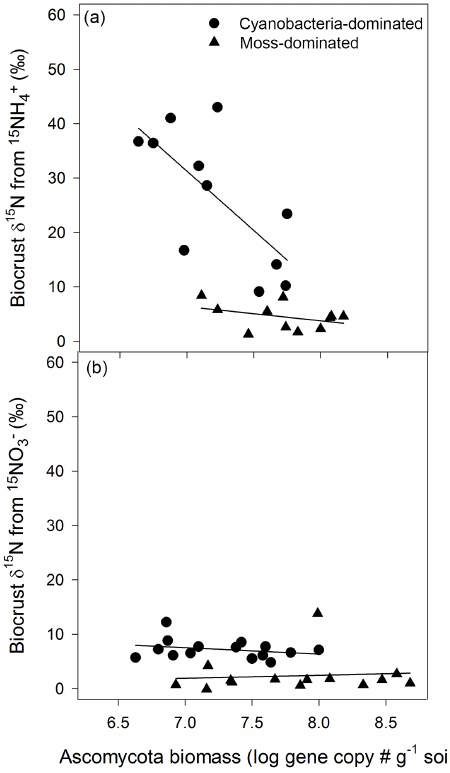
Figure 2. Ascomycota biomass influenced the distance N traveled. In cyanobacteria crusts, δ 15 N, from 15 NH + Figure 1. Cyanobacteria biocrusts facilitated the translocation of N Ascomycota gene copy number increased ( R 2 = 0 . 63, F 2 , 8 = 6 . 8, from 15 NH + in 24h. Based on linear mixed effects models, δ 15 N, 4 P = 0 . 02)( a ). A similar pattern was not apparent in any other crust from 15 NH + , ( R 2 = 0 . 67, F 2 , 12 = 11, P = 0 . 002), decreased as 4 type or N form (a, b) . Values are δ 15 N (‰) from biocrusts and As- the radial distance from the isotopic application increased (a) . There comycota gene copy numbers, an approximation of biomass, from was no such relationship between δ 15 N and the radial distance from qPCR of the ITS region with primer pair ITS5 and any other crust type or N form (a, b) . Values are δ 15 N (‰) from two biocrust types, cyanobacteria- and moss-dominated crusts, across circular plots (radius of 1.0m) with a central application (5cm di- ameter circle) of 15 NH + or 15 NO − in a simulated, minor rainfall 4 3 event.